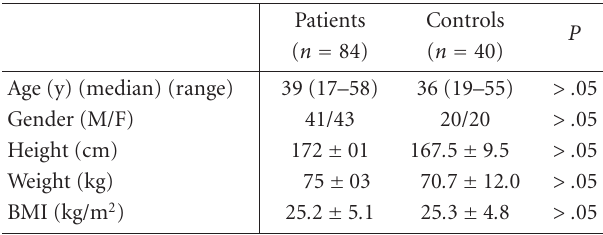
Table 1: The clinical and demographic characteristics of the psori- atic patients and the control group.